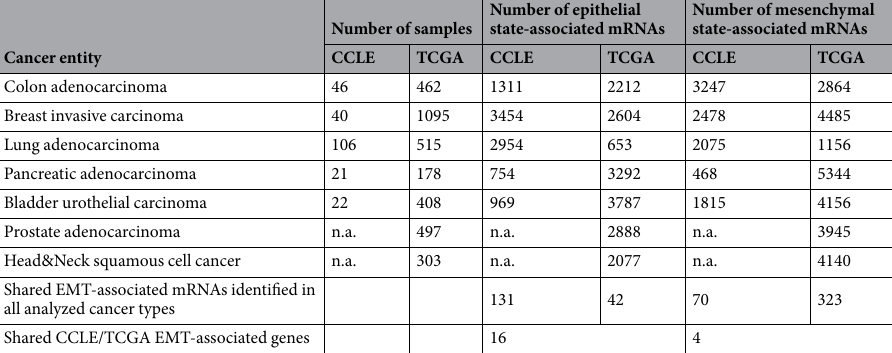
Table 1. Identification of mRNAs associated with epithelial- or mesenchymal-state as determined by analysis of CCLE and TCGA datasets derived from indicated cancer entities. In the CCLE screen, epithelial-state associated mRNAs were defined as mRNAs that showed a significantly higher expression in epithelial-like cancer cell lines compared with mesenchymal-like cell lines. Mesenchymal-state associated mRNAs were defined as mRNAs that showed a significantly higher expression in mesenchymal-like cancer cell lines compared with epithelial- like cell lines. Significance was calculated by a Student’s t-test (p < 0.05 was considered significant). n.a., not analyzed. In the TCGA screen, epithelial-state associated mRNAs were defined as mRNAs that positively correlated with expression of the epithelial marker CDH1 (r > 0.1) and negatively correlated with expression of the mesenchymal marker VIM (r < − 0.1). Mesenchymal-state associated mRNAs were defined as mRNAs that negatively correlated with expression of the epithelial marker CDH1 (r < − 0.1) and positively correlated with expression of the mesenchymal marker VIM (r >